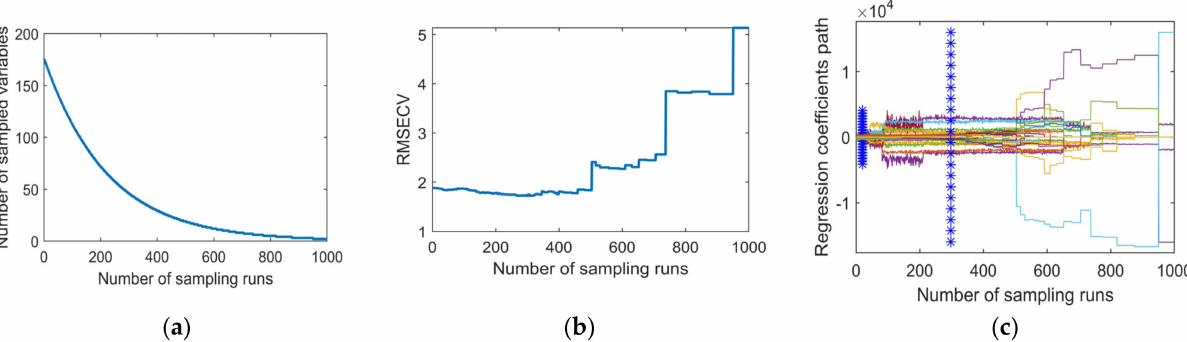
Figure 7. Characteristic variable selection process of sCARS algorithm. ( a ) Changes in the number of waveband variables. ( b ) Validation of RMSECV. ( c ) Path of variable regression